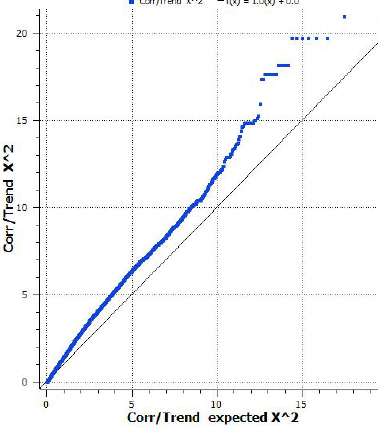
Figure 3. ( A ) Manhattan and ( B ) QQ plot of the GWAS analysis of IMF % in Duroc-sired pigs ( n = 40). The red line indicates the threshold for genome-wide significance ( P < 4.5 × 10 − 8 ) for 68,529 SNPs adjusted for sex and MAF < 0.01. The QQ plot shows a distribution of expected IMF % values that are skewed when their SNPs are correlated on the extreme end of the data for the Duroc samples.